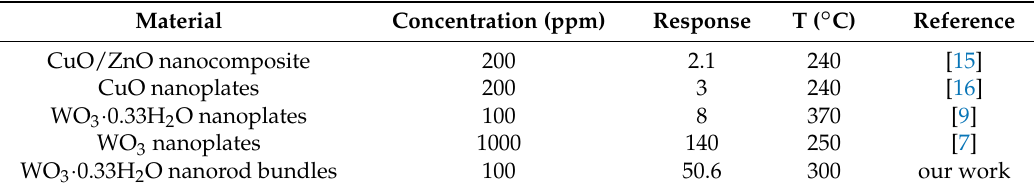
Table 1. List of metal oxide-based ethanol sensors.